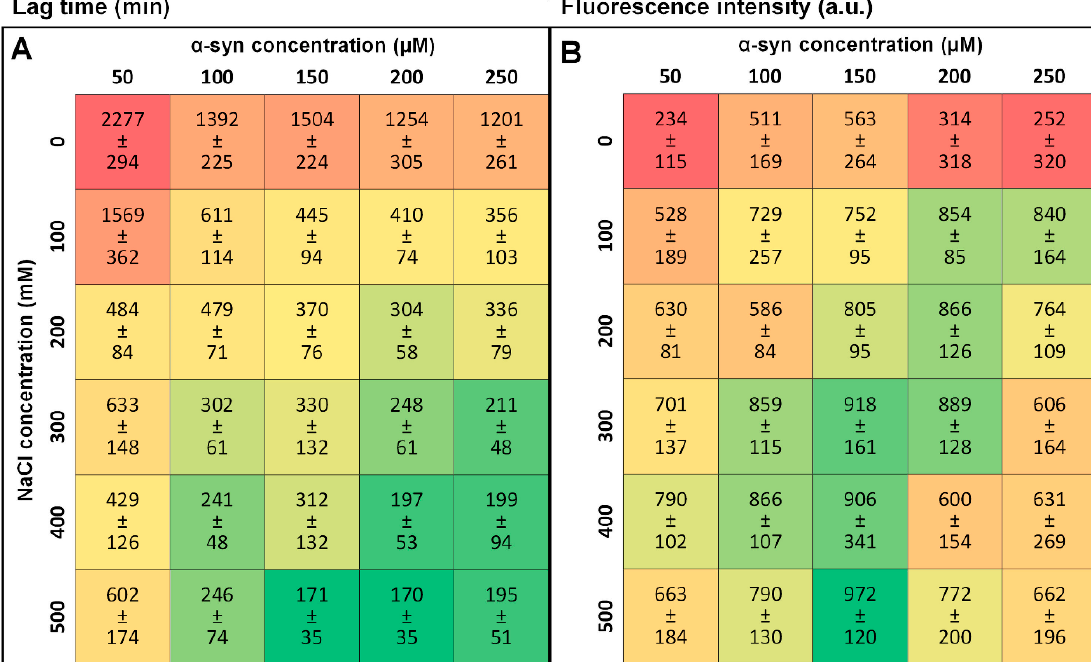
Figure 1. Alpha-synuclein aggregation lag time ( A ) and bound-ThT fluorescence intensity ( B ) dependence on protein concentration and solution ionic strength. Lag time and fluorescence intensity values and standard deviations were calculated from 90–96 repeats. Lag time color-coded boxes indicate a shift from long (red) to short lag times (green). Fluorescence intensity color-coded boxes indicate a shift from low (red) to high (green) intensity. Aggregation kinetic raw data are available as Supplementary Material.